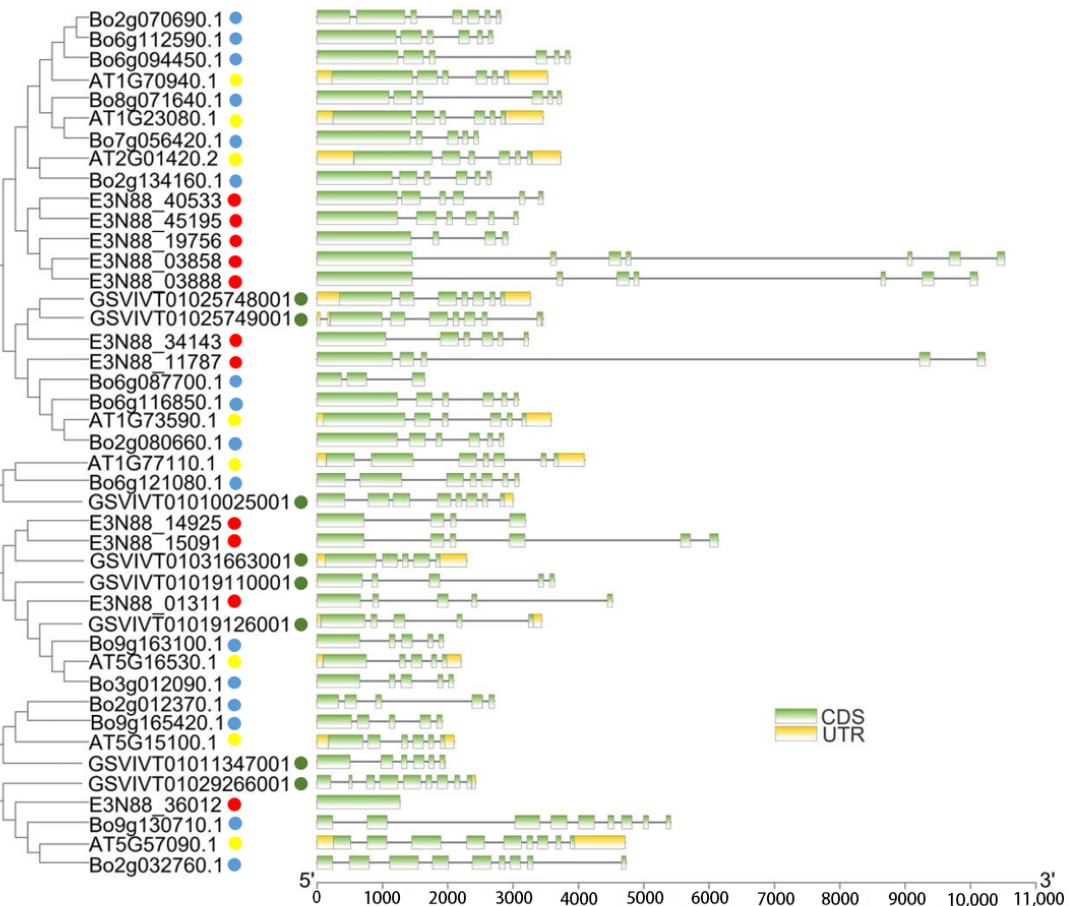
Figure 3. Exon–intron organization of PIN genes in M. micrantha , A. thaliana , B. oleracea and V. vinifera . Green boxes represent exons, untranslated regions (UTRs) are indicated by yellow boxes, and black lines represent introns. The lengths of the boxes and lines are scaled based on gene length. The exon and intron sizes can be estimated using the scale at the bottom. M. micrantha , A. thaliana , B. oleracea and V. vinifera are distinguished by solid circle shapes in red, yellow, blue and green, respectively.